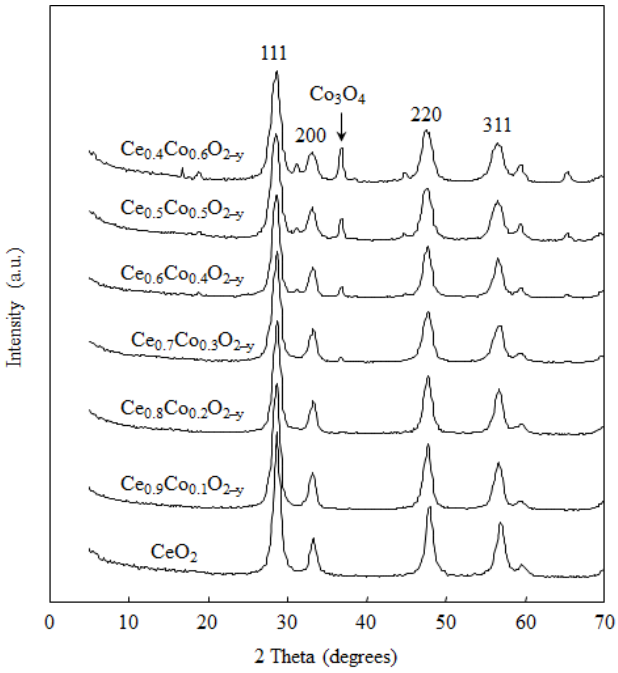
Figure 1. X-ray diffraction patterns of Ce 1 − x Co x O 2 − y prepared by homogeneous precipitation after calcination at 723 K for 3 h.